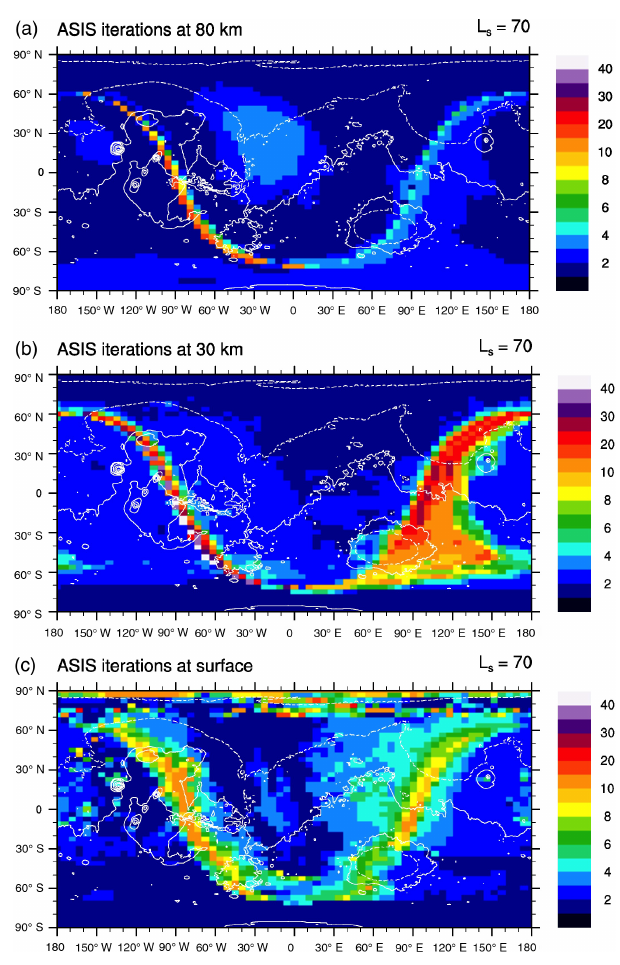
Figure 10. Number of sub-time-steps per time interval of 15min in the LMD Mars GCM in northern spring (instantaneous result at solar longitude Ls = 70 ◦ and day 150 of the simulation). Three al- titude levels are represented at 80km (a) , 30km (b) , and the sur- face (c) . Local noon is located at longitude zero. The white contour represents topography, with a 4km